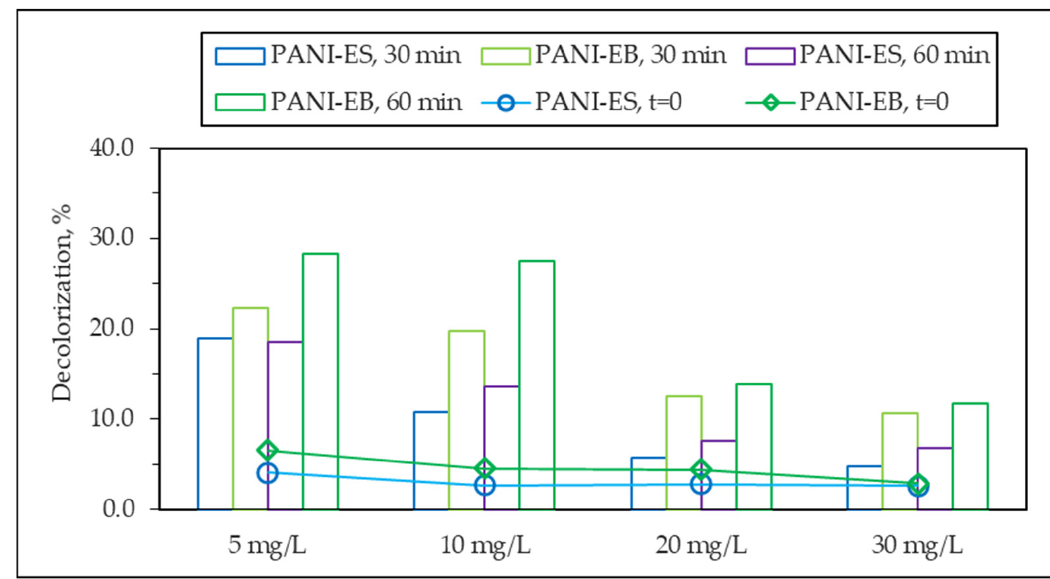
Figure 13. Photocatalytic degradation of MB upon use of PANI-ES and PANI-EB: Initial MB concentration effect. PANI-ES specimen: 3.13 > 2.26 > 0.816 > 0.394 for 30 mg/L, 20 mg/L, 5 mg/L and